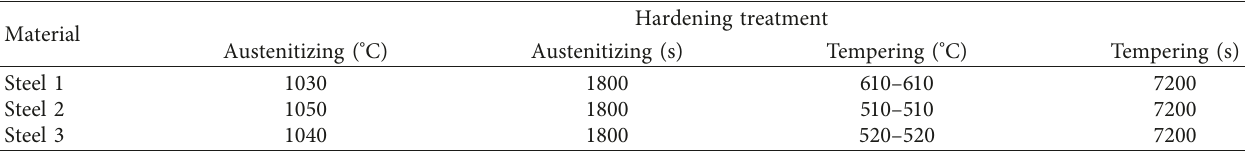
Table 2: Heat treatment of hot work tool steels.